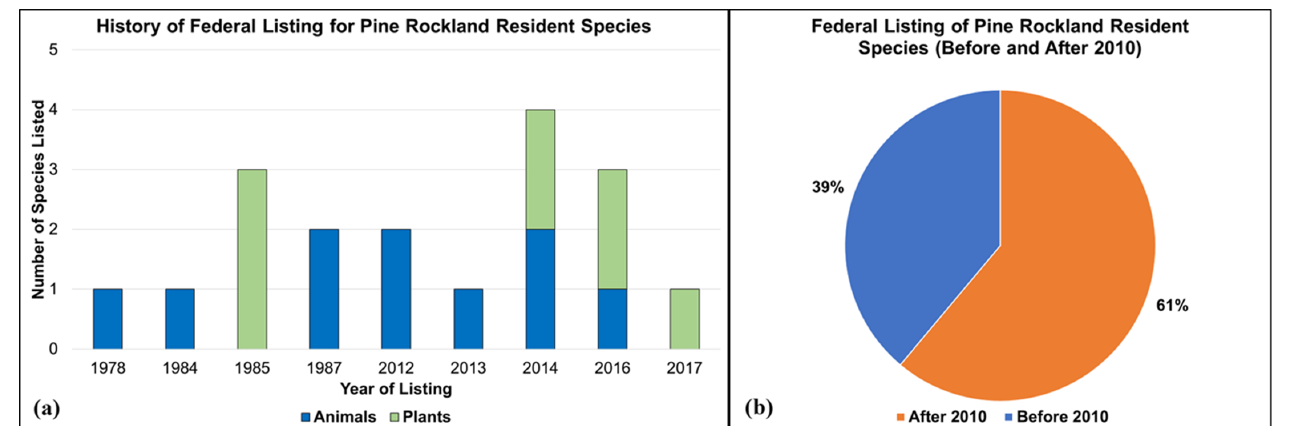
Figure 2. History of federal listing for pine rockland resident species. ( a ) Histogram illustrating the history and number of federal species listings from 1978 to present. ( b ) Pie chart showing the percent of pine rockland resident species listings before and after 2010. Data were extracted from the USFWS Environmental Conservation Online System.